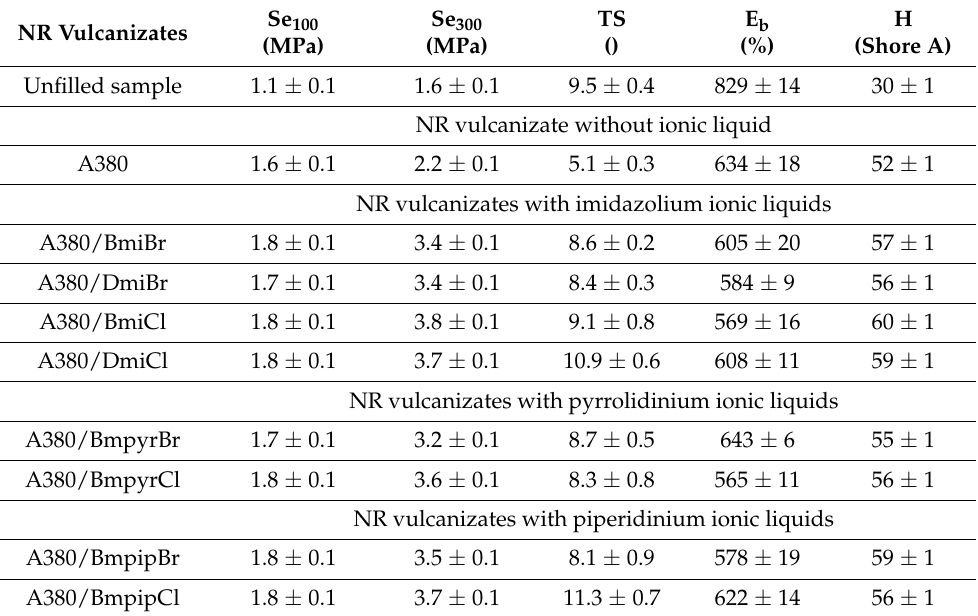
Table 6. Mechanical properties and hardness of the silica-filled NR vulcanizates containing ILs (SE 100 , stress at 100% relative elongation; SE 300 , stress at 300% relative elongation; TS, tensile strength; EB, elongation at break; H,